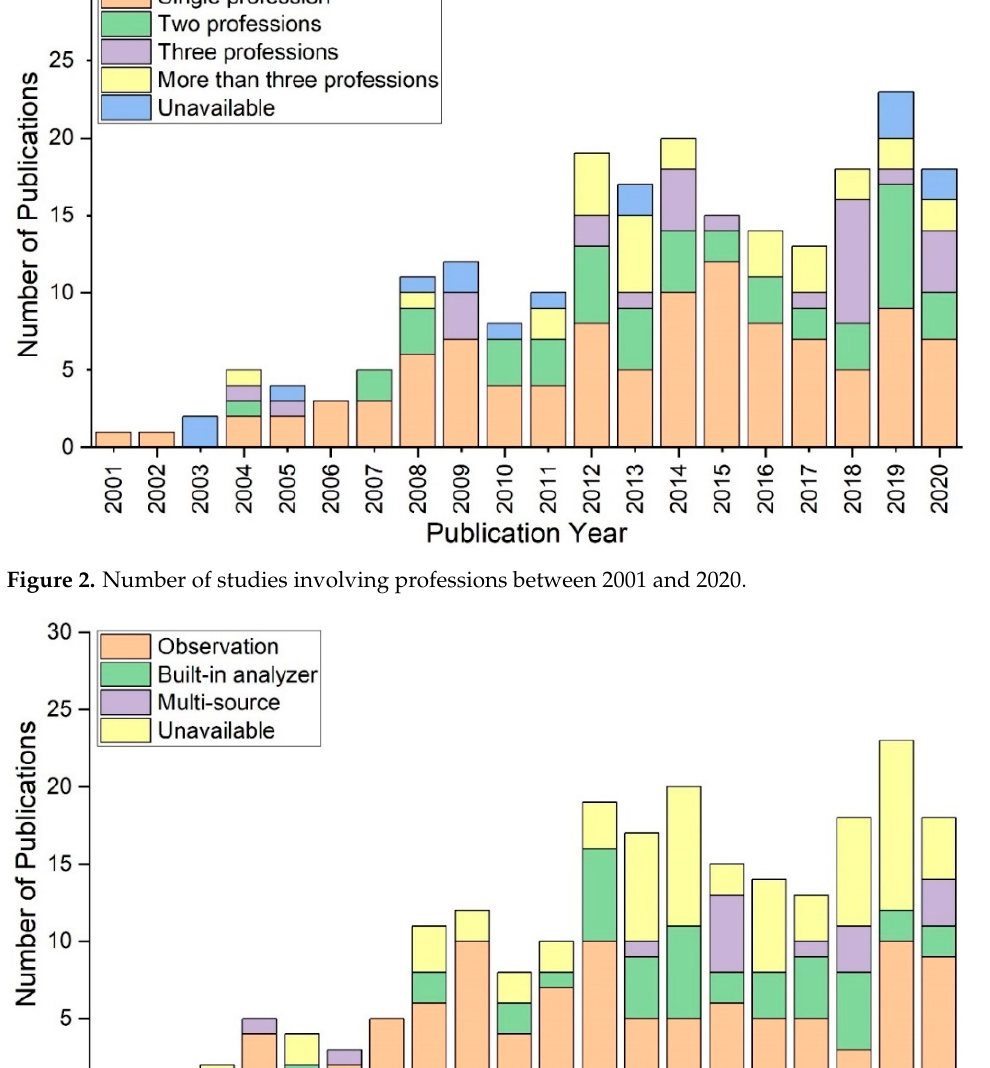
Figure 2. Number of studies involving professions between 2001 and 2020.